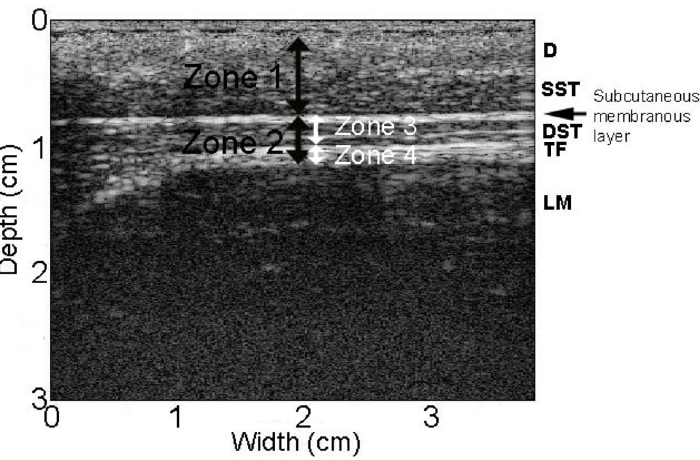
Fig 3. Location of tissue zones used for measurement of tissue thickness in ultrasound images. D: dermis, SST: superficial subcutaneous tissue, DST: deep subcutaneous tissue, TF: thoracolumbar fascia.